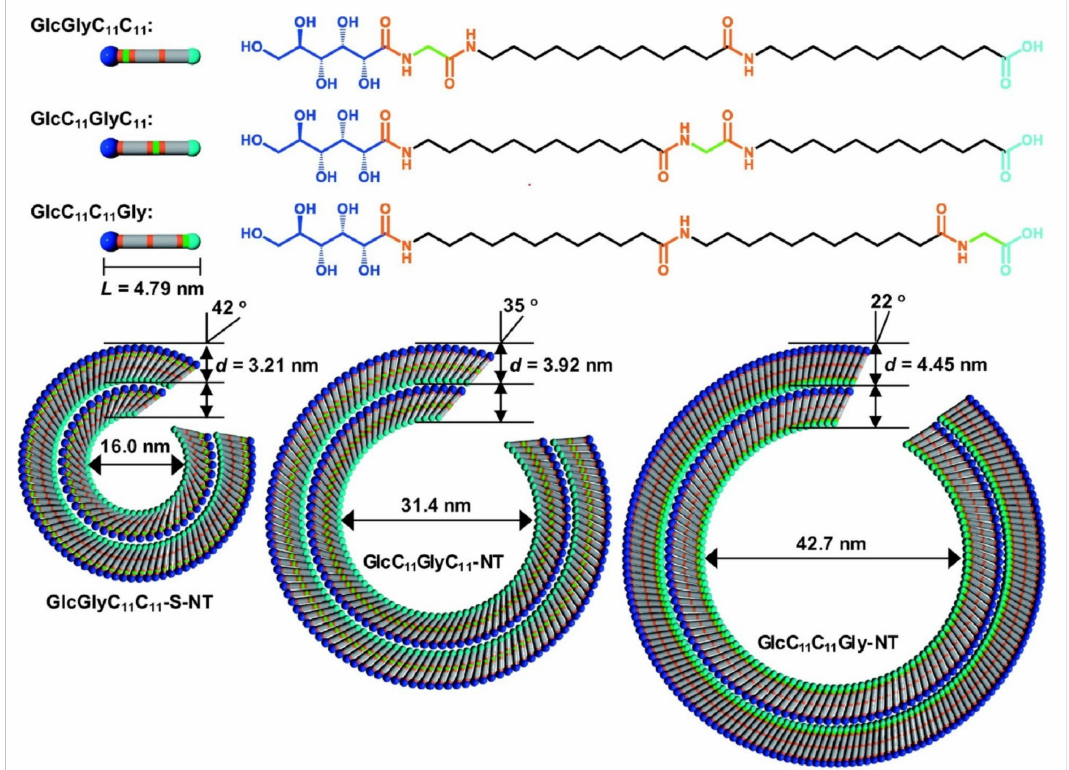
Figure 7. Formation of nanotubes with different inner diameters upon self-assembly of three asym- metrical bolaamphiphile-type glycolipids having common moieties of glycine, 12-aminododecanoic acids, and D-gluconolactone and different connection sequences. Reprinted with permission from Reference [126]. Copyright 2021 Chemical Society of